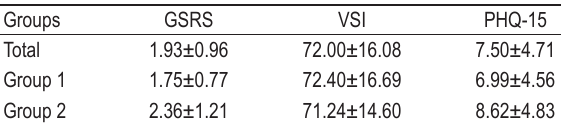
TABLE 2. Description of questionnaires filled by all participants and according to subgroups (Data are expressed as: